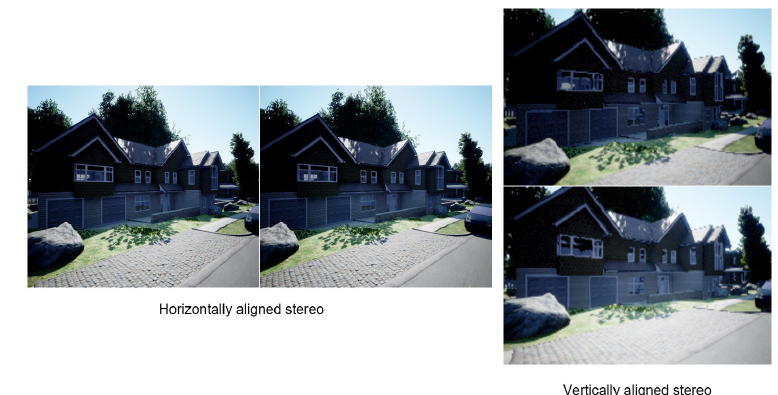
Figure 10. Two different possible configurations, horizontal stereo configuration and vertical stereo configuration obtained from